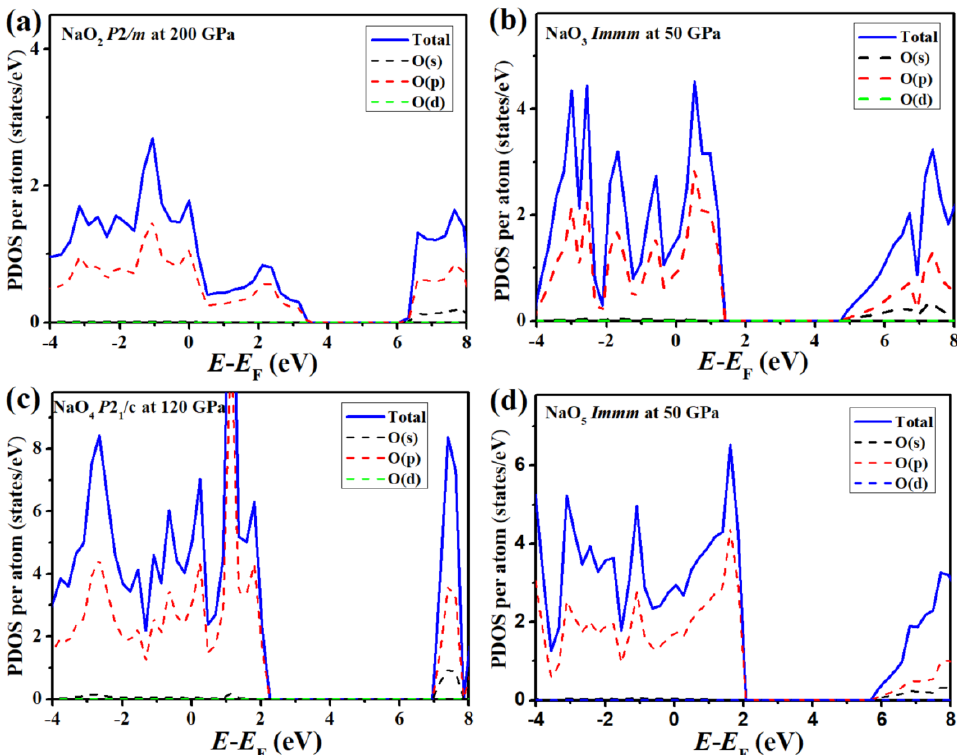
Figure 3. PDOS of the predicted O − rich Na − O compounds: ( a ) P 2 /m NaO 2 at 200 GPa; ( b ) Immm NaO 3 at 50 GPa; ( c ) P 2 1 /c NaO 4 at 120 GPa; ( d ) Immm NaO 5 at 50 GPa. The PDOS of Na is not shown, as it had negligible contributions near the Fermi energy. The Fermi energy (E F ) was set to zero.